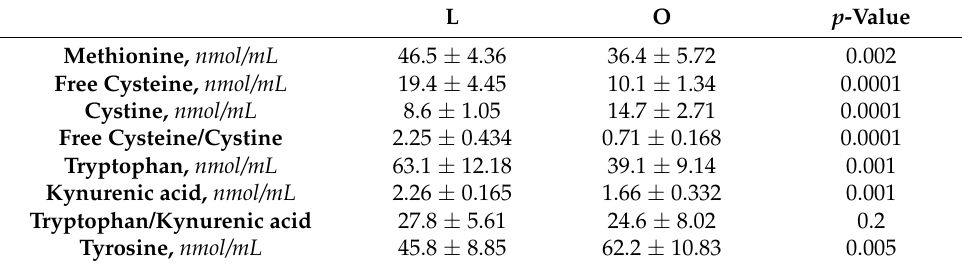
Table 1. Serum metabolite concentration of lean and obese Zucker rats. L O p -Value Methionine, nmol/mL 46.5 ± 4.36 36.4 ± 5.72